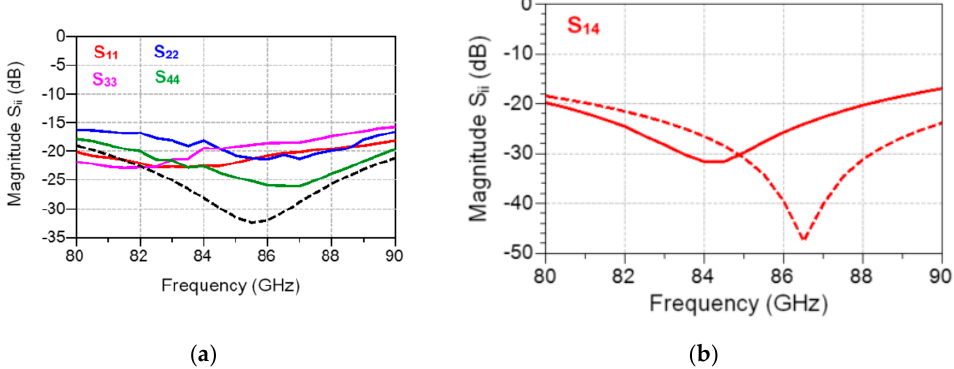
Sensors 2020 , 20 , x FOR PEER REVIEW Figure 30. MHMIC 90° hybrid coupler: ( a ) transmission; ( b ) phase difference. Figure 30. MHMIC 90 ◦ hybrid coupler: ( a ) transmission; ( b ) phase di ff erence.